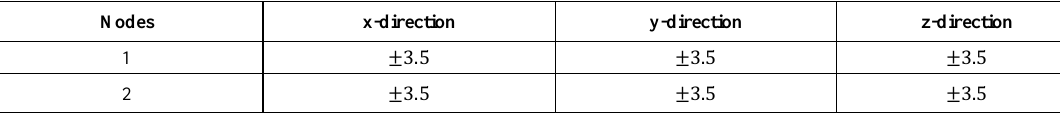
at the nodes {1} and 0